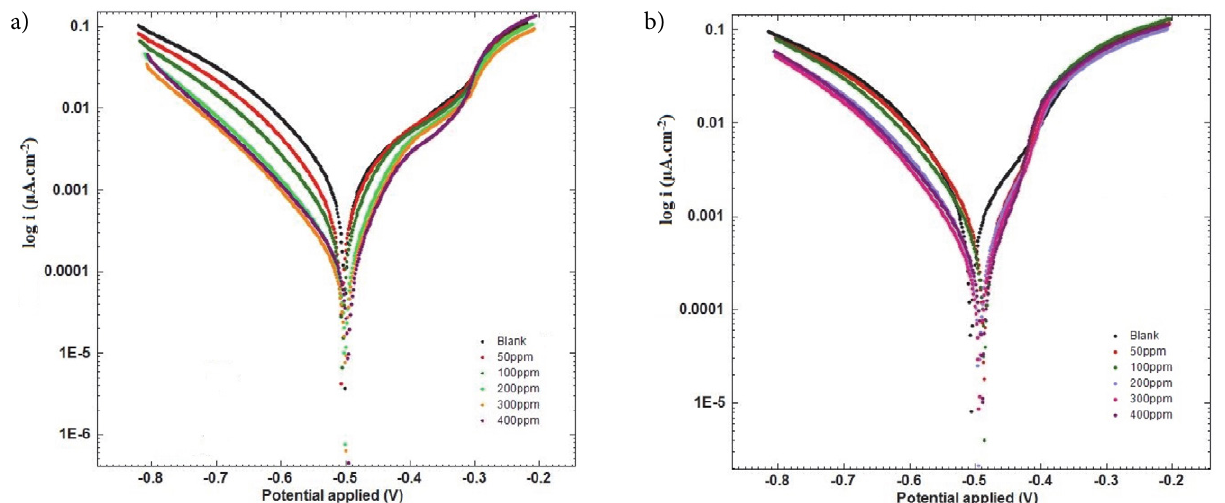
Figure 4. Polarization curves for mild steel in a) 1 M hydrochloric acid and b) 0.5 M sulfuric acid solution in absence and presence of different concentrations of inhibitor at 25 ± 1 °C. (The experiments were repeated at least two times)